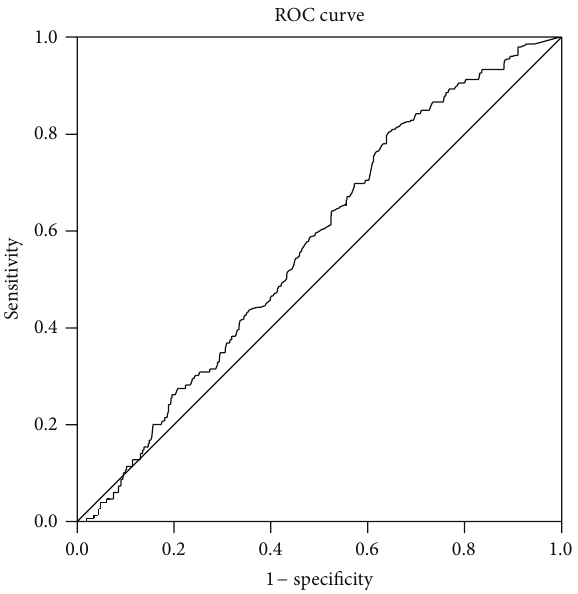
Figure 2: ROC curve for cancer prediction in a model for preoperative TSH